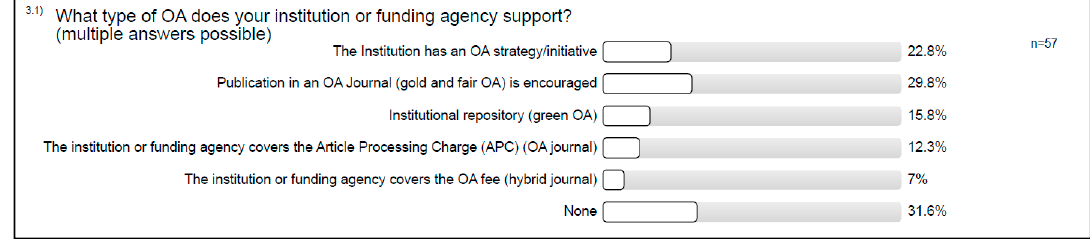
Figure 4. Type of institutional OA support.